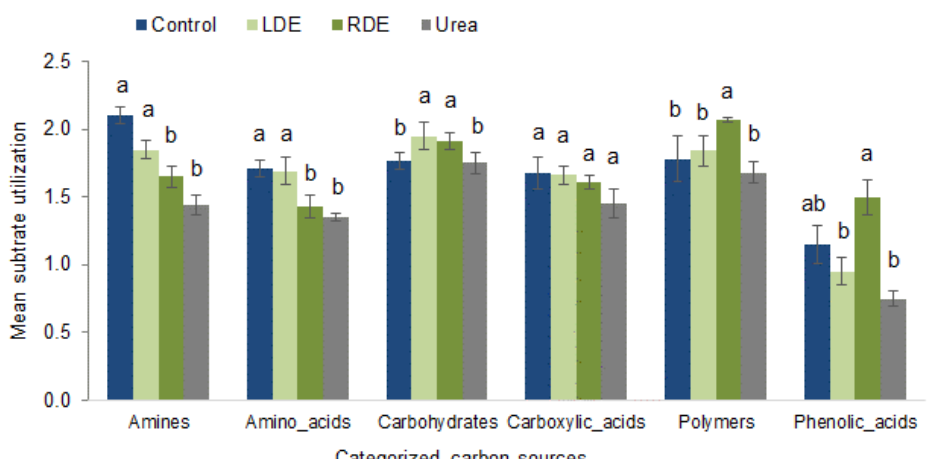
Figure 4. Substrate utilization patterns of different carbon sources by soil microbial community after 96 h of incubation in Biolog EcoPlates upon the application of RDE, LDE, urea, or non-amended control to pots containing fescue pasture soil. Values represent means ± standard error ( n = 3). Significant differences between treatments in each carbon substrate’s group utilization are indicated with different letters ( p < 0.05).